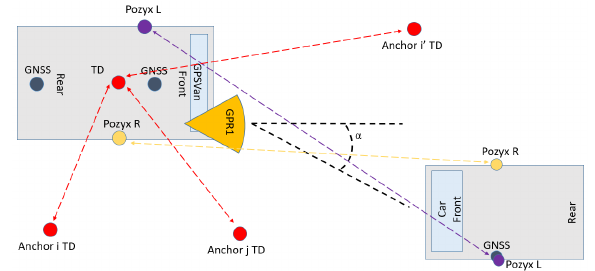
Figure 2. Sensor configuration.